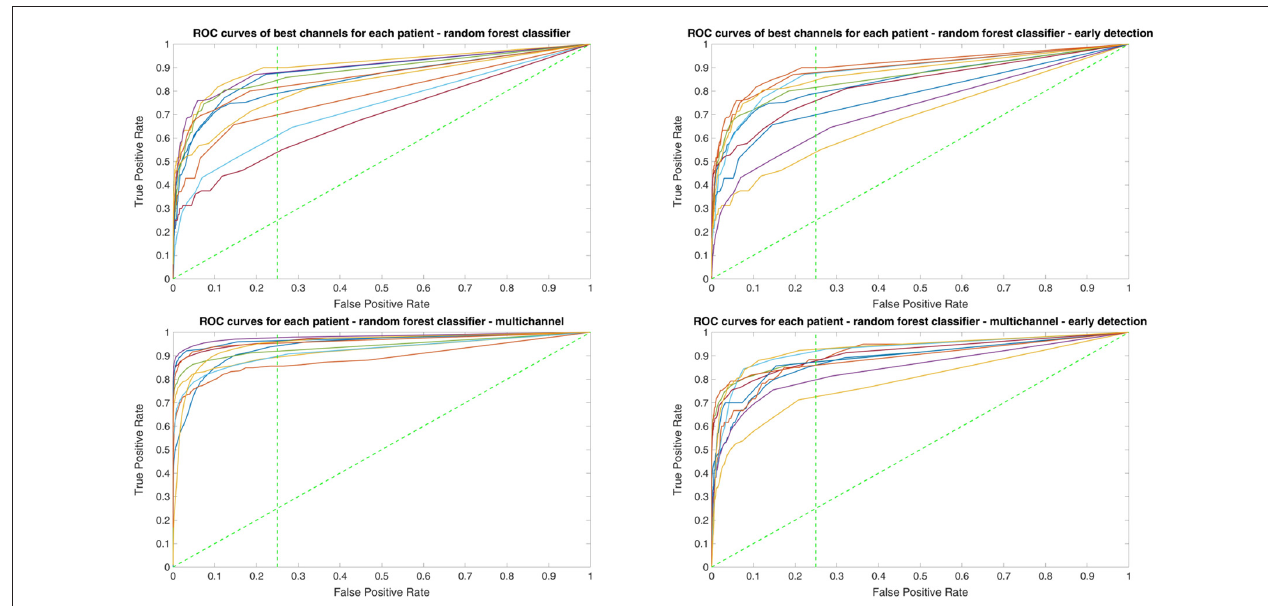
FIGURE 5 | ROC curves of all patients in single and multichannel mode for the Random Forest classifier. The dashed line separates the early retrieval area.